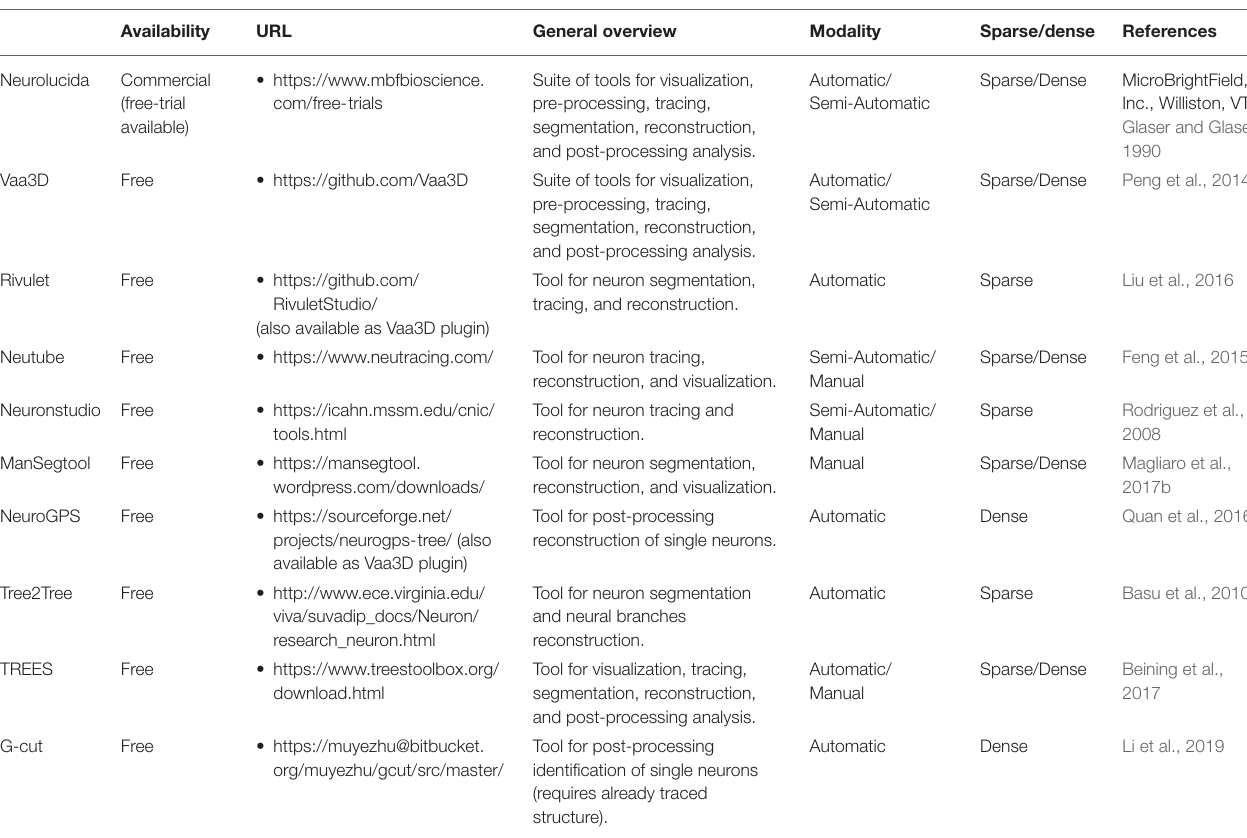
TABLE 2 | Principal state-of-art tool for segmenting